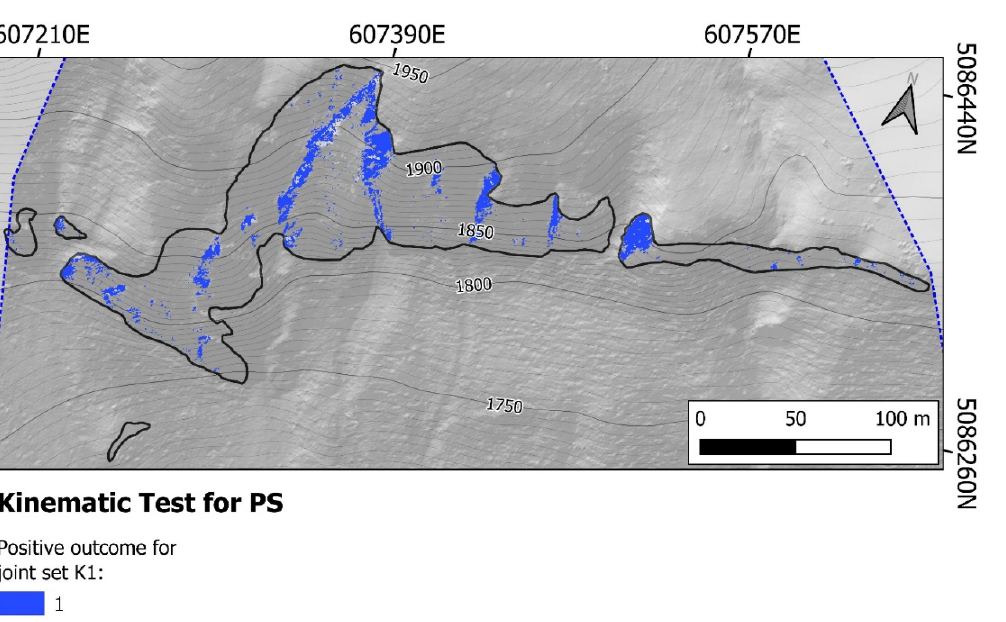
Figure A1. Image of the partial output file showing the kinematic test for PS performed considering only joint set K1.